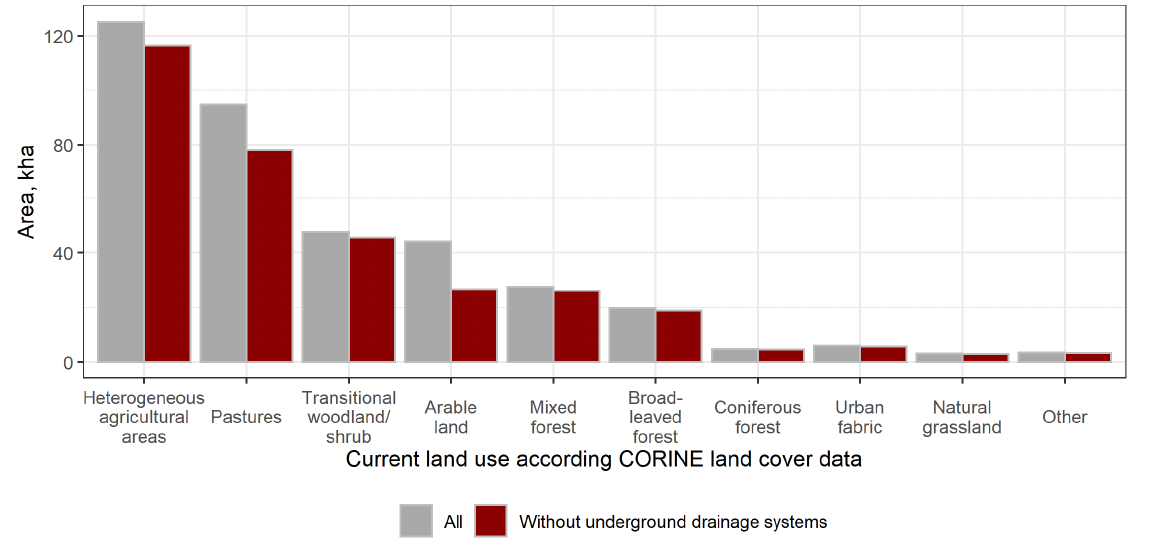
Figure 7. Area of low ‐ value agricultural land parcels suitable for agroforestry by current land use according to the CORINE land ‐ cover data. according to the CORINE land-cover